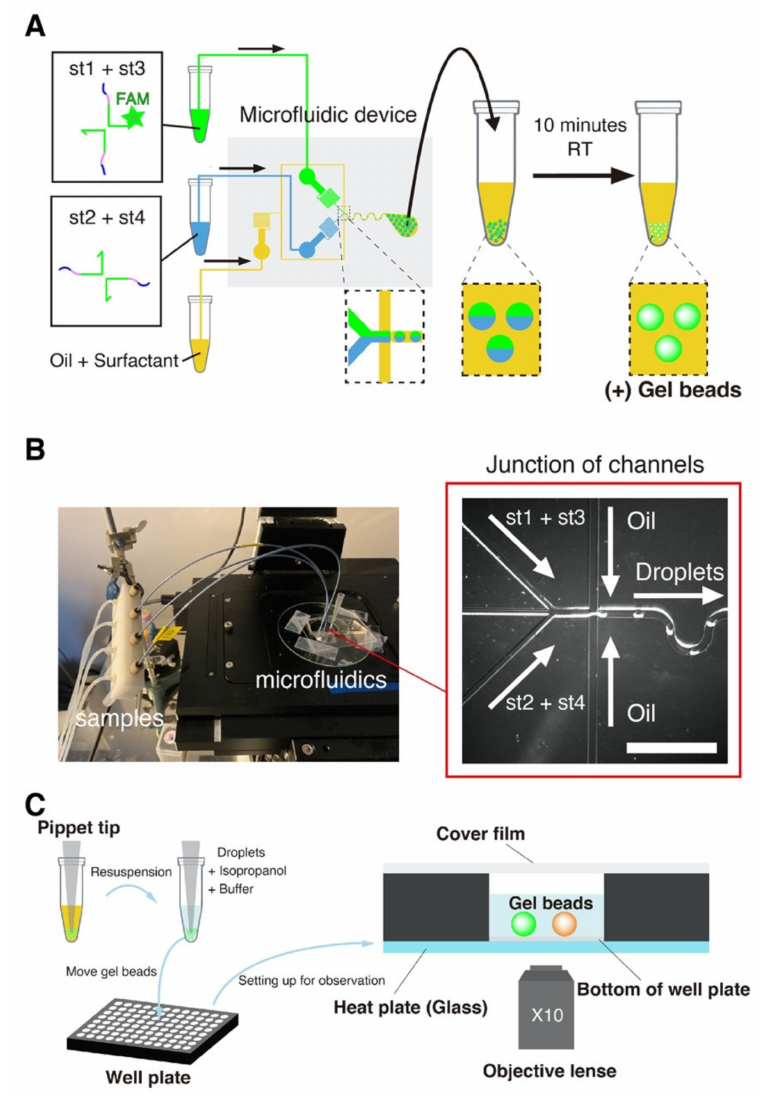
Figure 2. The microfluidic platform for gel beads generation. ( A ) The four strands forming the DNA gel were split into two channels to prevent premature gelation in the device. The two channels meet immediately before a flow-focusing junction, which intersects the aqueous channel with an oil channel. Monodisperse droplets of water in oil are generated at the exit of the junction. After collection, the emulsion was left at room temperature for at least 10 min to allow the DNA strands to gelify. ( B ) Image of the microfluidic platform setup (left). The samples are connected to the device with PEEK tubes directly planted in PDMS. A tip at the outlets collects the water-in-oil emulsion, which creams at top of the tip due to the density of the oil phase. The blowup (right, bright field) shows the junction where droplets are generated. The scale bar is 150 µ m. ( C ) Resuspension of the DNA gel beads. After incubation at room temperature, the oil phase is removed and the beads are resuspended in an aqueous buffer. Beads are extracted by mixing them with isopropanol and buffer, and then resuspending them in a larger volume of buffer in a well. The 96-well plate is mounted onto a microscope stage with a transparent glass heat plate for